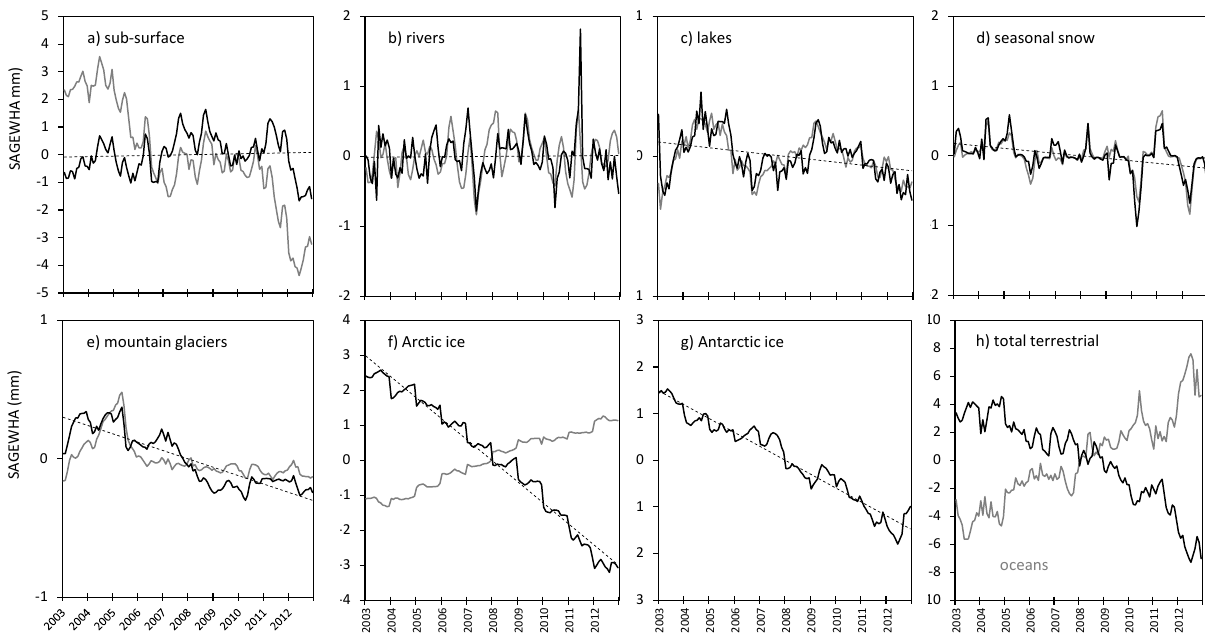
Figure 6. Time series of the prior (grey lines) and posterior (black lines) estimates of seasonally adjusted global equivalent water height anomalies (SAGEWHA) in different water cycle components. Dashed lines show linear trends for 2003–2012 as listed in Table 3. Table 4. Evaluation of alternative estimates of mean basin discharge using observations collated by Dai et al. (2009). Listed is the agreement for the ensemble models (without bias correction), the merged prior estimate and the posterior estimates resulting from reanalysis. CLM MOS NOAH